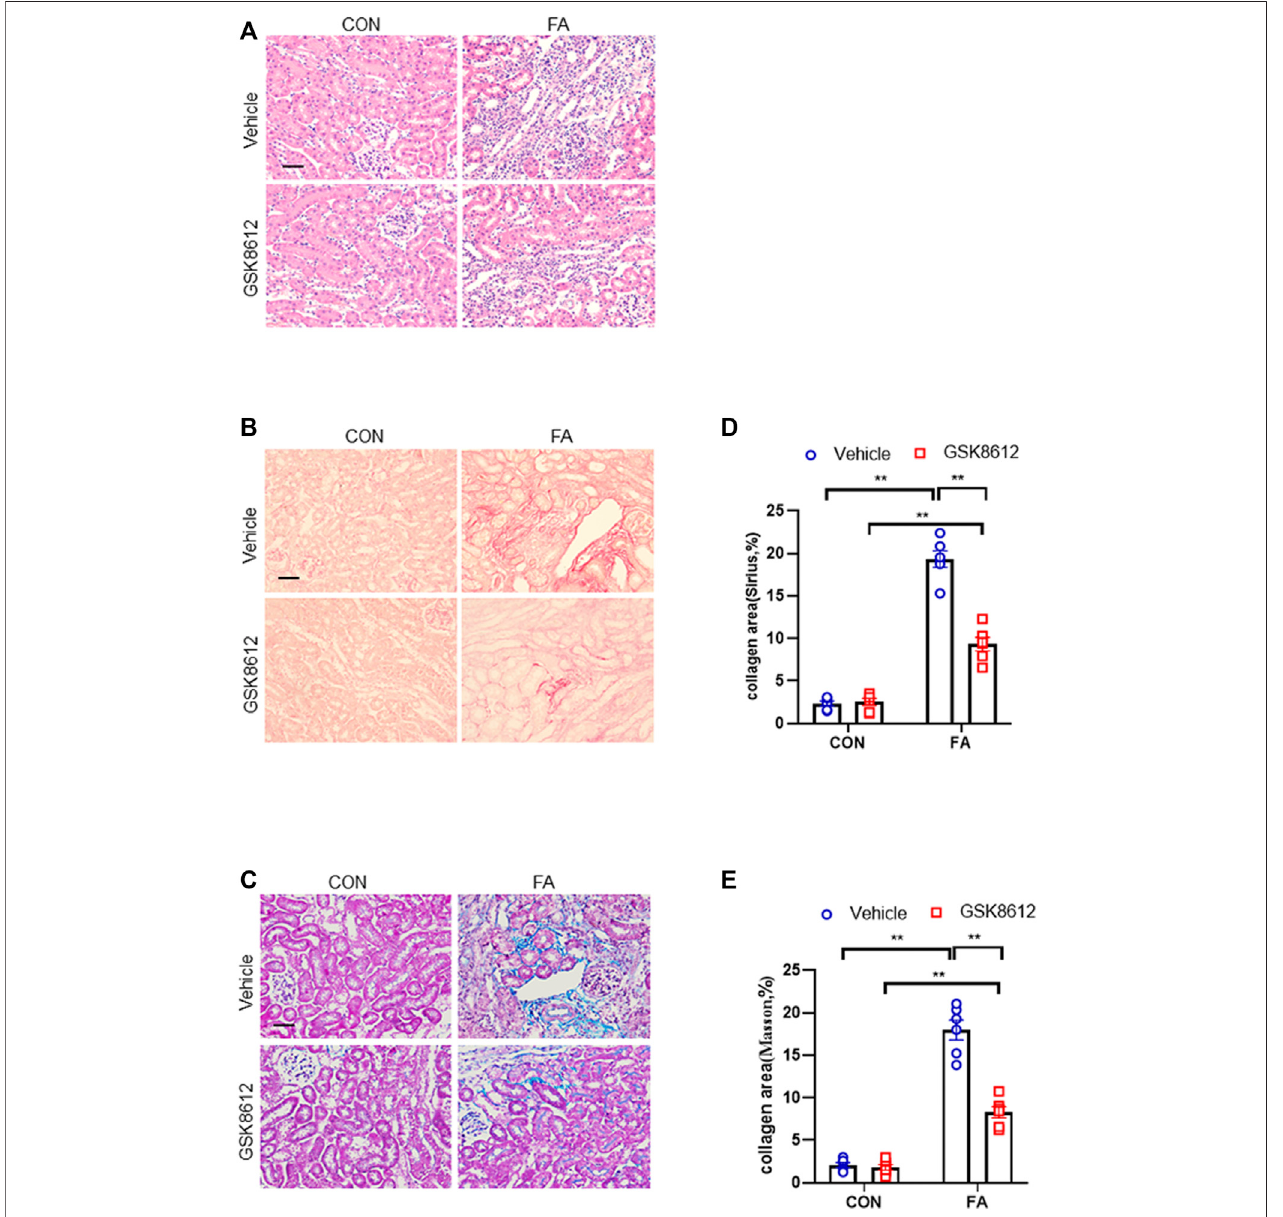
FIGURE 7 | Pharmacological inhibition of TBK1 protects against progressive renal fi brosis in FA nephropathy. (A) Representative photomicrographs of kidneys sections in each group stained with H&E. (B) Representative photomicrographs of kidney sections stained with Sirius red. (C) Representative photomicrographs of kidneysectionsstainedwithMasson ’ strichrome. (D,E) QuantitativeanalysisofinterstitialcollagenareastainedwithSiriusredorMasson ’ strichromeinthekidneys.** p < 0.01; n = 6 in each group; Scale bar: 50 μ m.